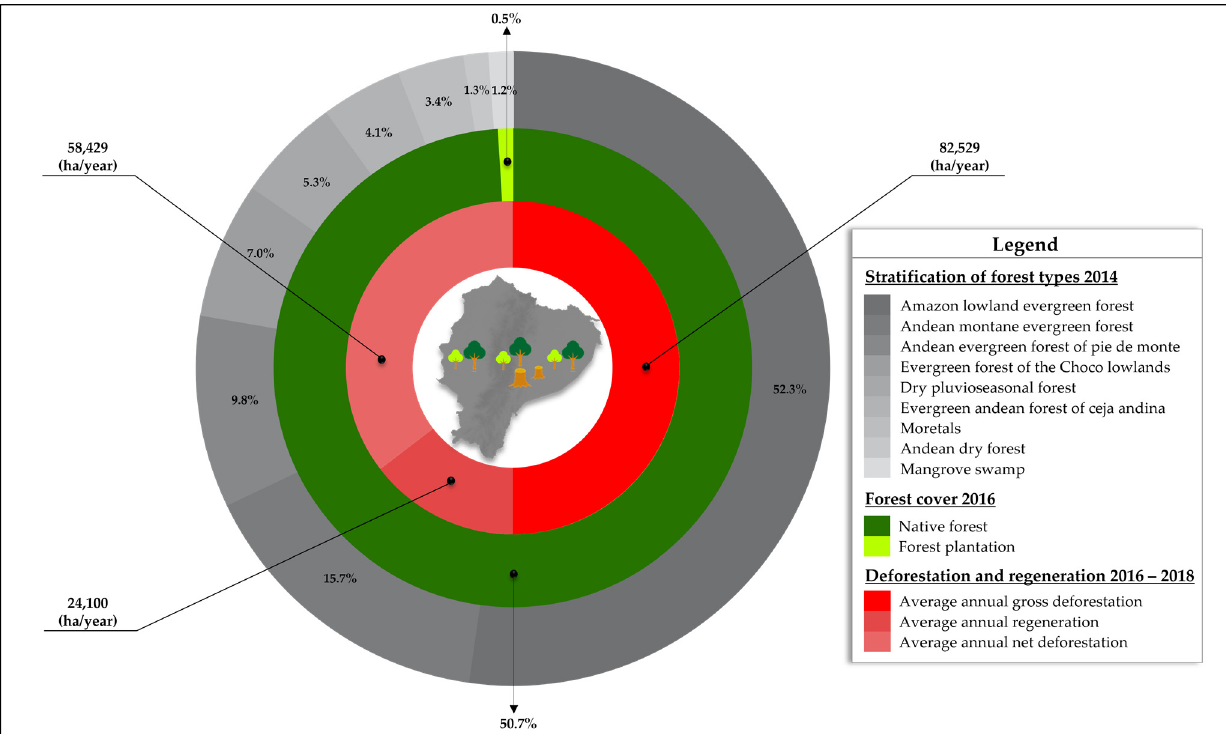
Figure 4. Stratification of forest types of Ecuador in 2014, forest cover (native and planted) in 2016, and deforestation and regeneration in the period of 2016–2018.